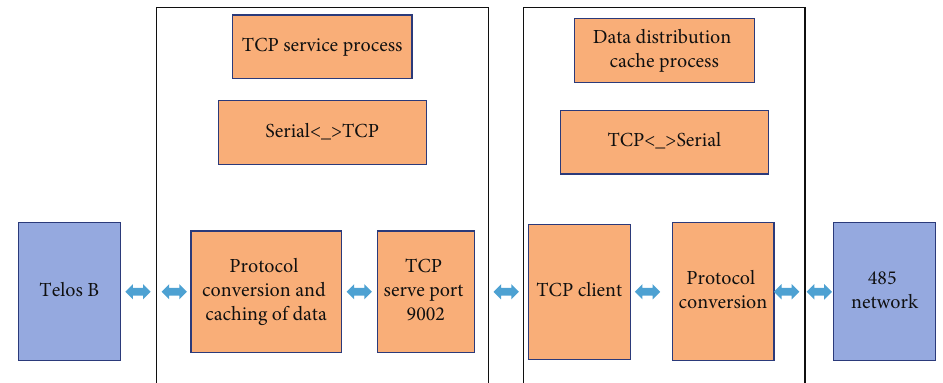
Figure 6: Platform design process and composition.